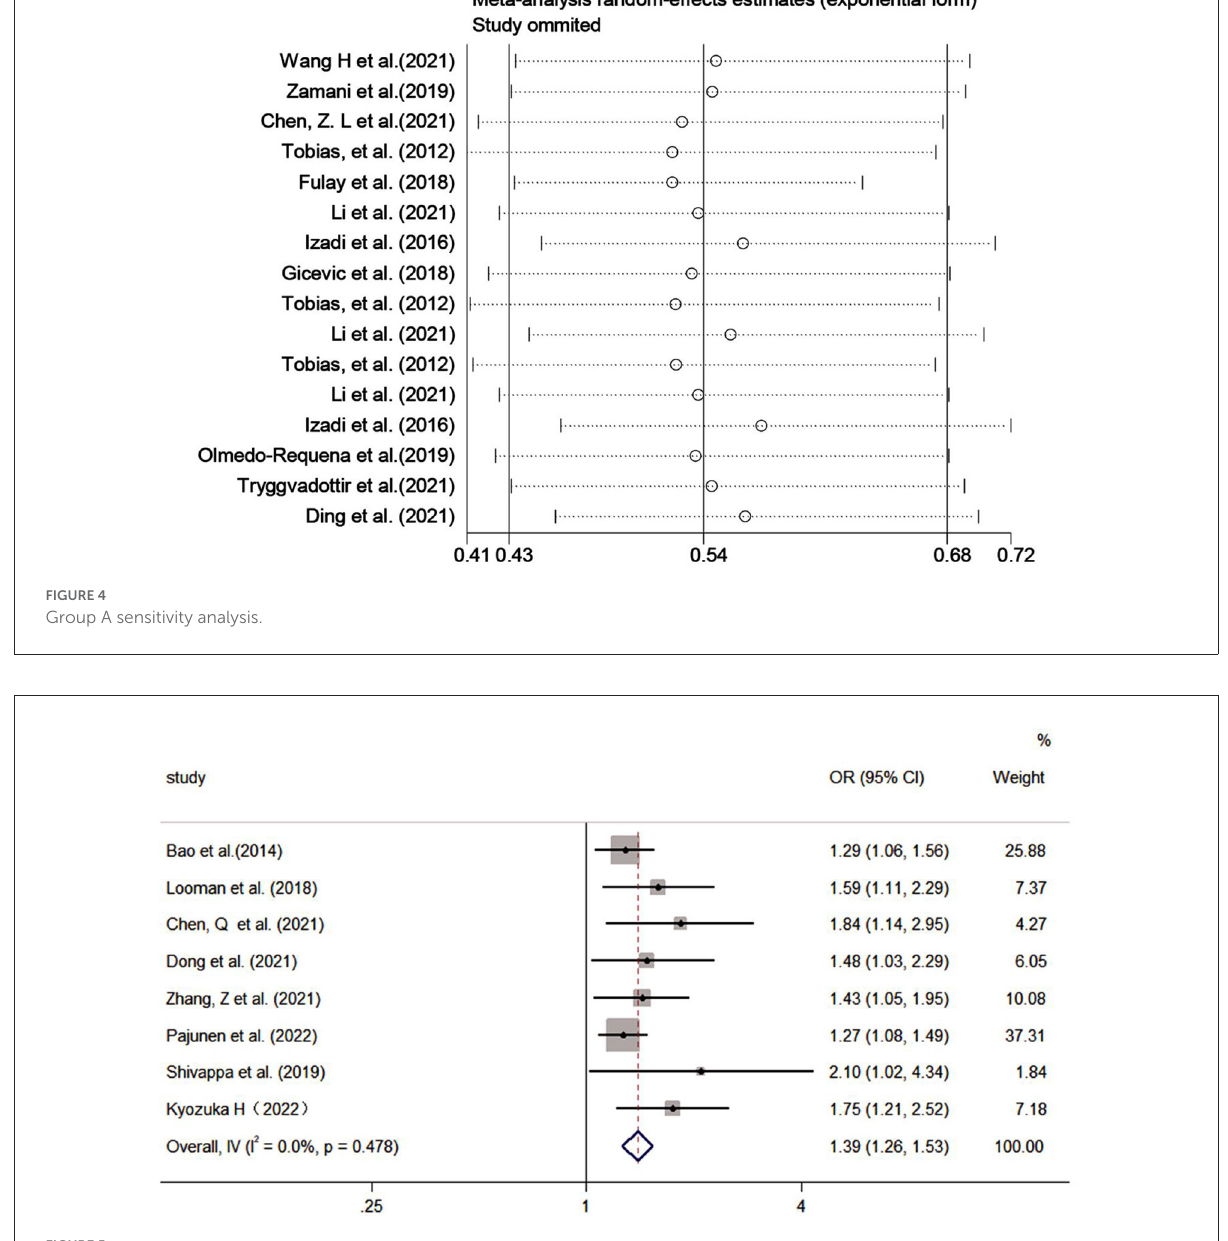
FIGURE5 Forest plot for the association of the Group B with